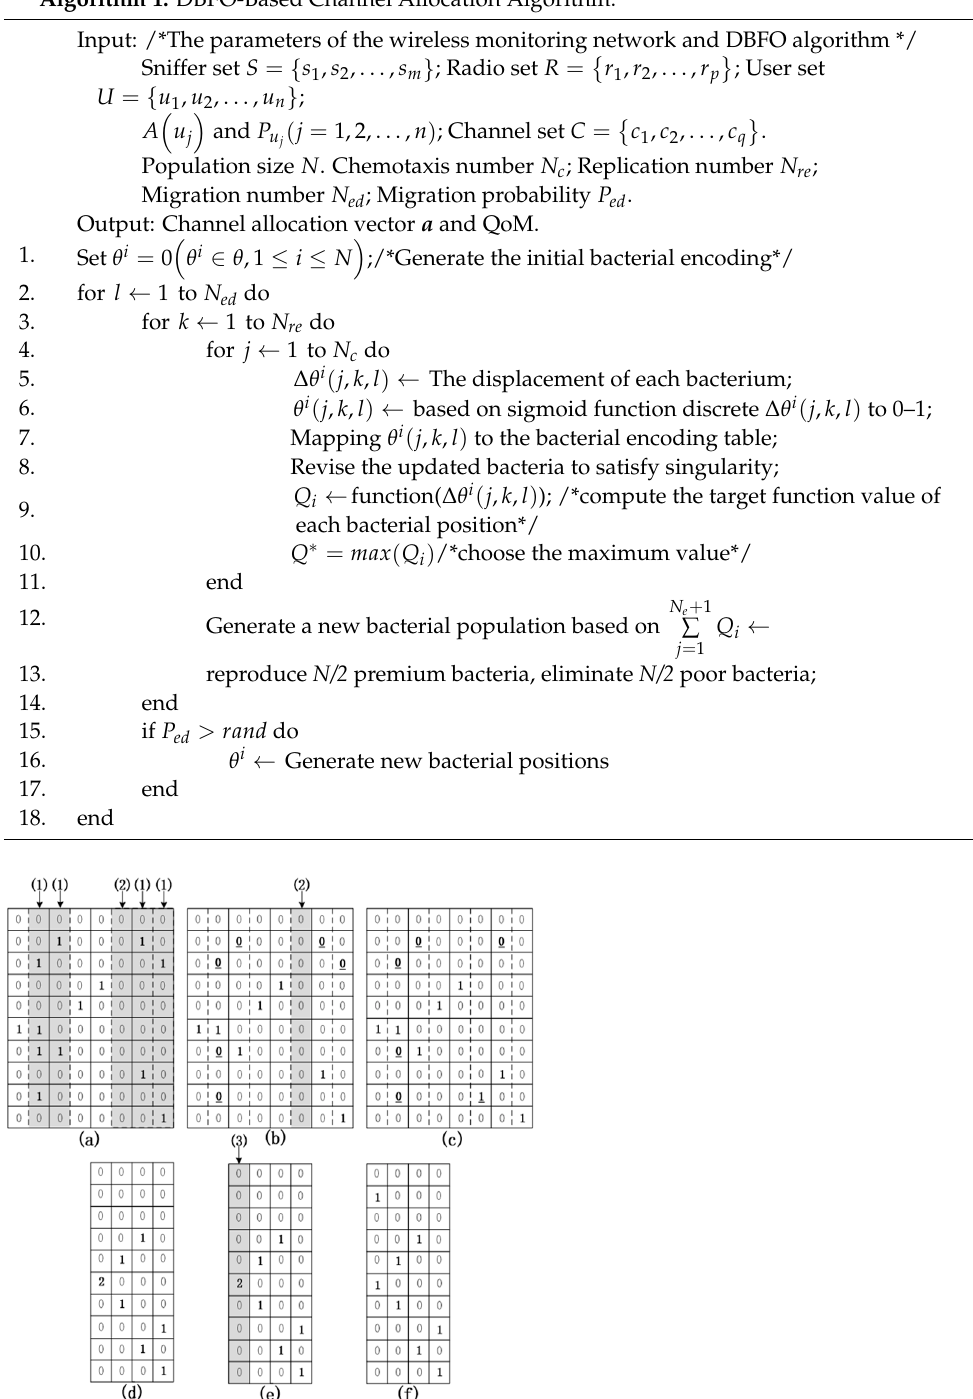
Figure 11. Revised process after updating the encodings. ( a ) indicates the coding after updating bacterial positions at a certain time, ( b ) corresponds to the cumulative coding table after Step 2 correction, ( c ) corresponds to the coding table after the Step 3 correction, ( d ) represents the cumulative coding table in Case 1, ( e ) represents the cumulative coding table in Case 2, ( f ) represents the coding table after the reassignment of radios for the multiplexed channel in ( e ).